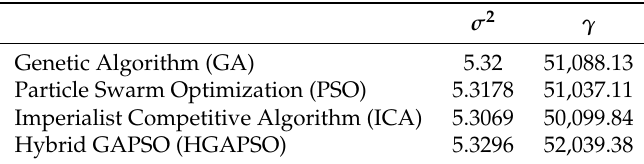
Table 2. The hierarchy of extracted patents on climate change mitigation